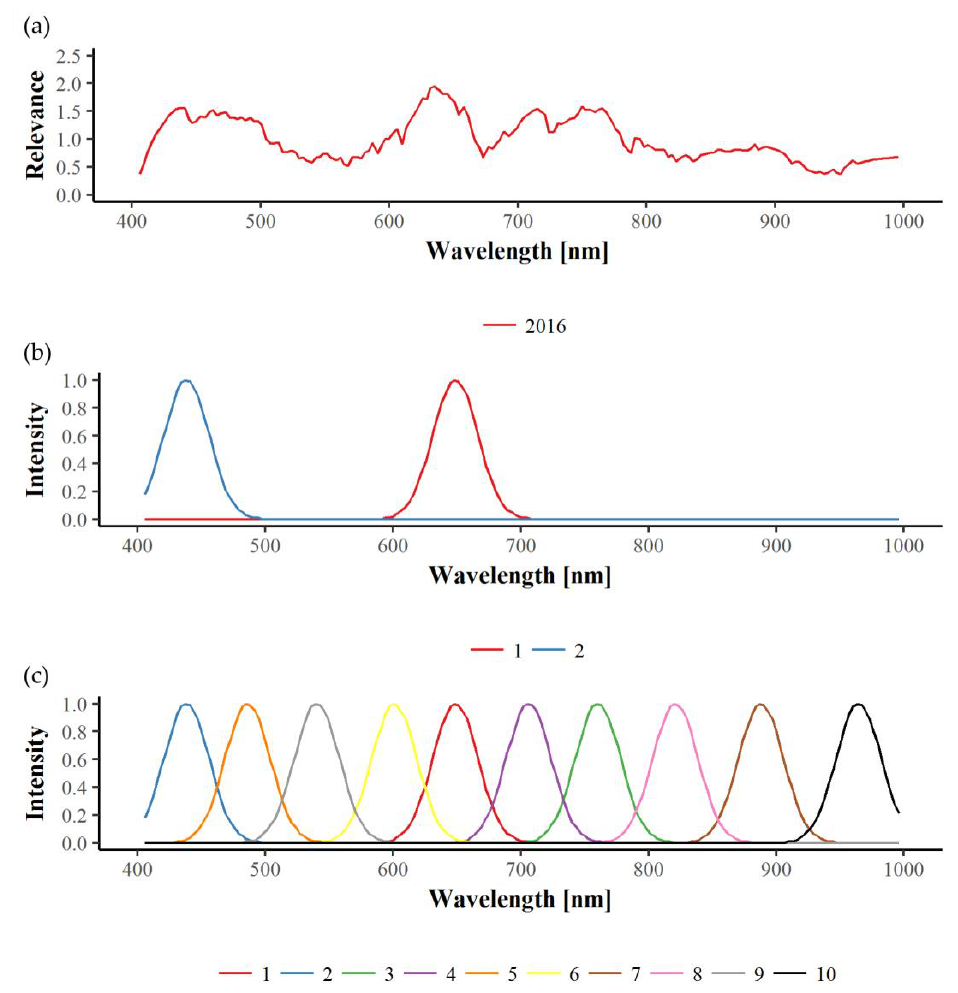
Figure 3. Example of the band selection process in the VNIR range for GLRaV-1 symptom detection of white cultivars in 2016. According to the relevance profile ( a ), multispectral bands can be selected starting with the two most informative. ( b ) Single bands can be added until a maximum of ten is reached ( c ).